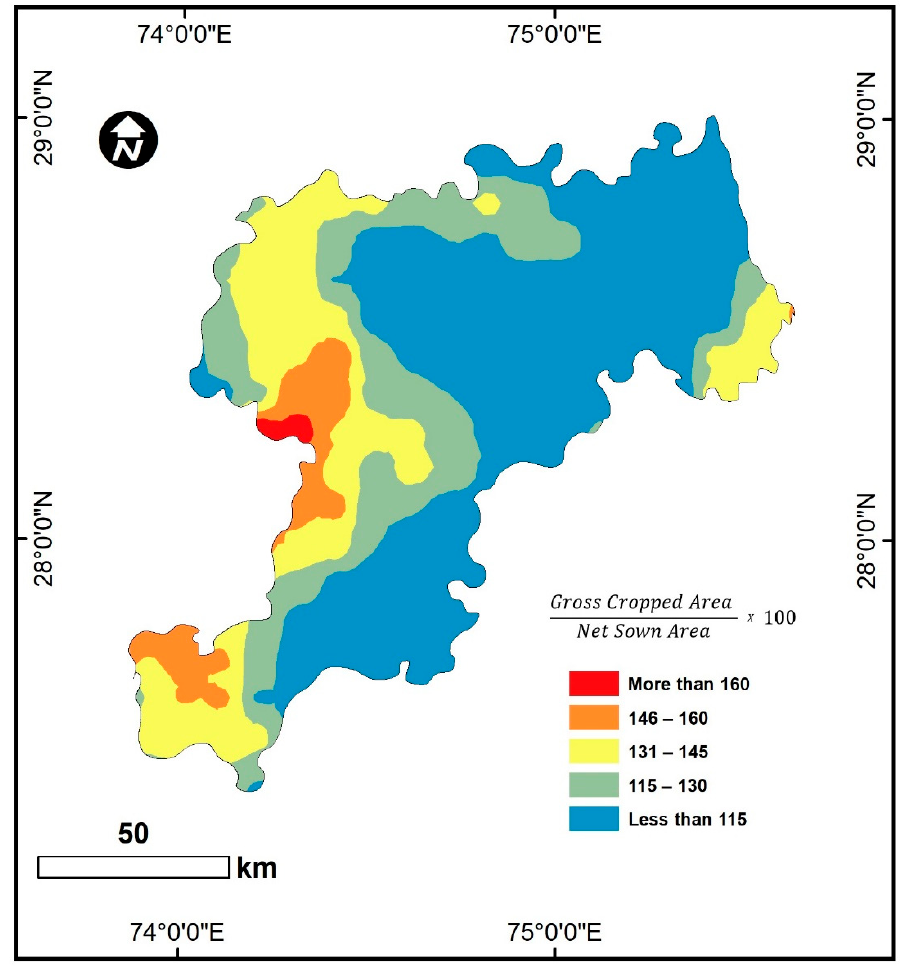
Figure 11. Cropping intensity map (Datum: WGS84).